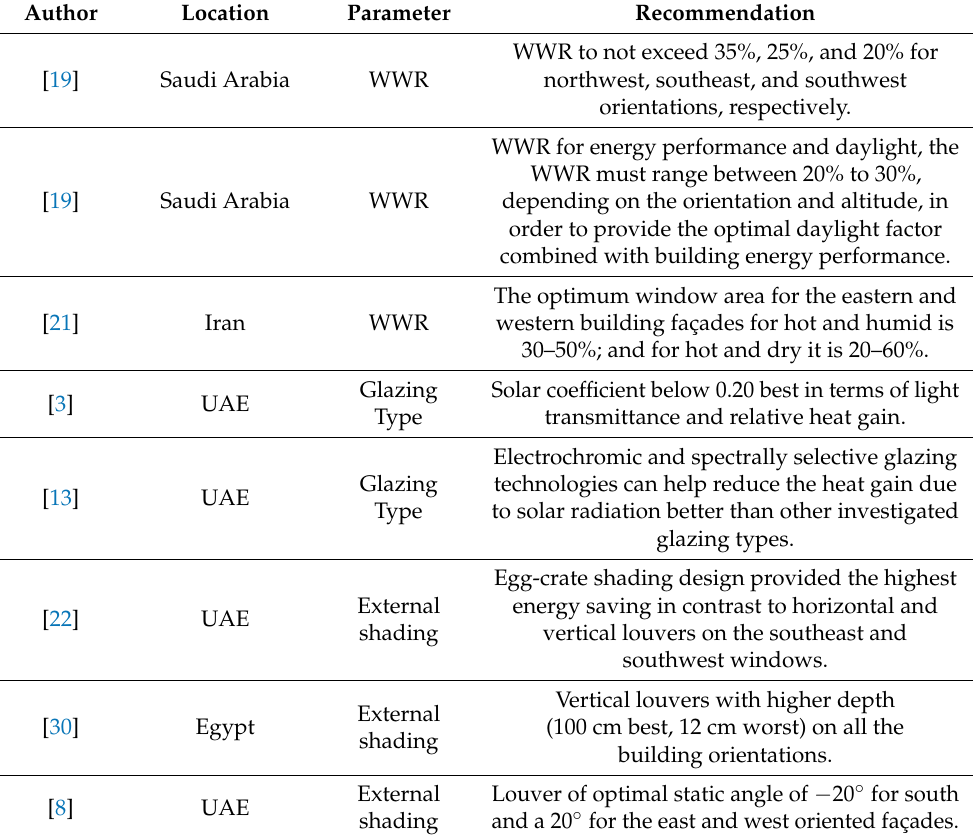
Table 1. A summary of notable literature recommendations for fenestration façade design parameters in hot arid